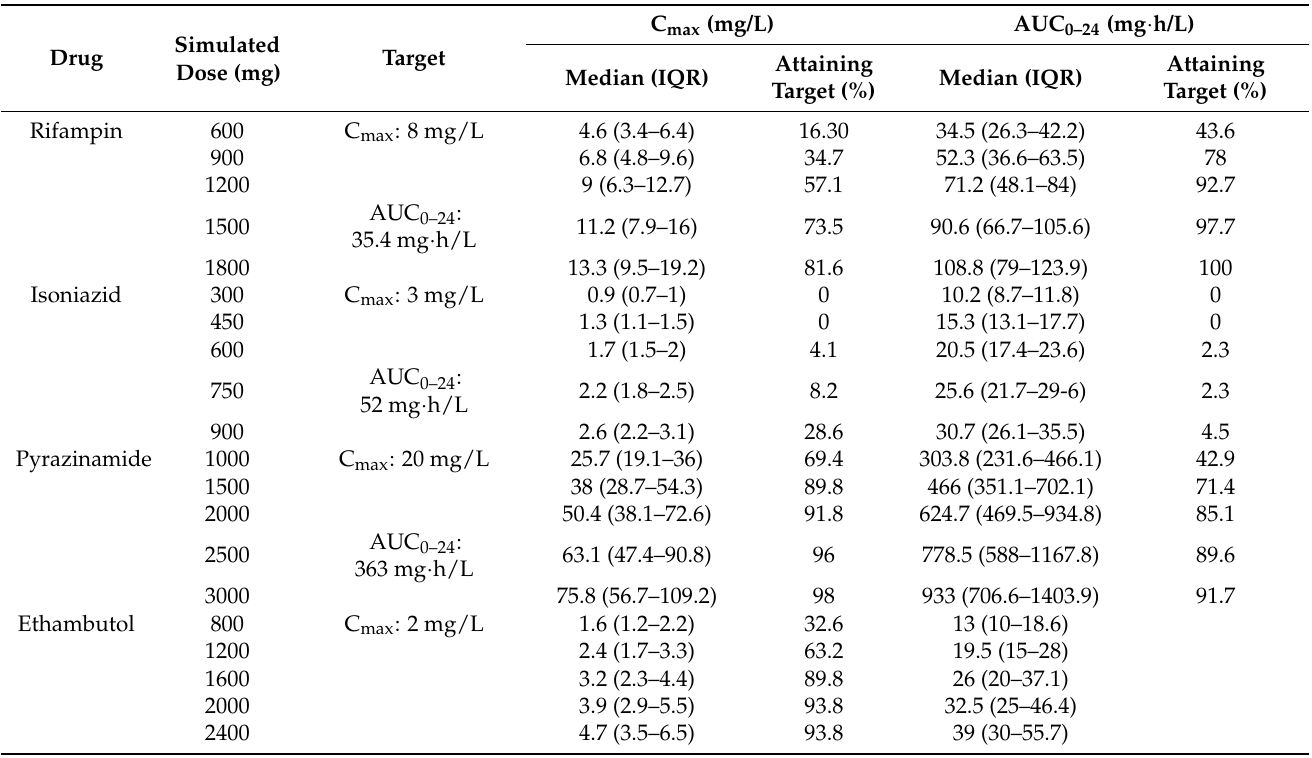
Table 4. Summary of pharmacokinetic measurements and percentage attaining target at various simulated doses. C max